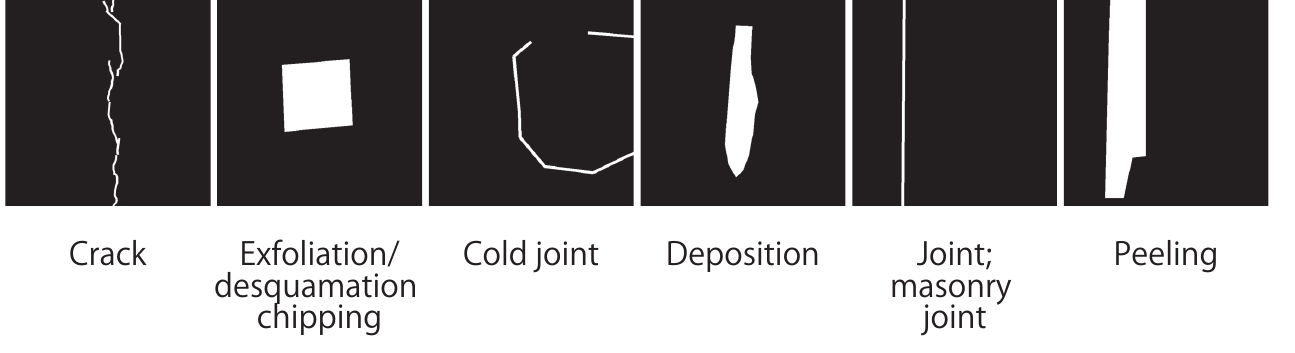
Figure 4. Examples of labels in the dataset, corresponding to Figure